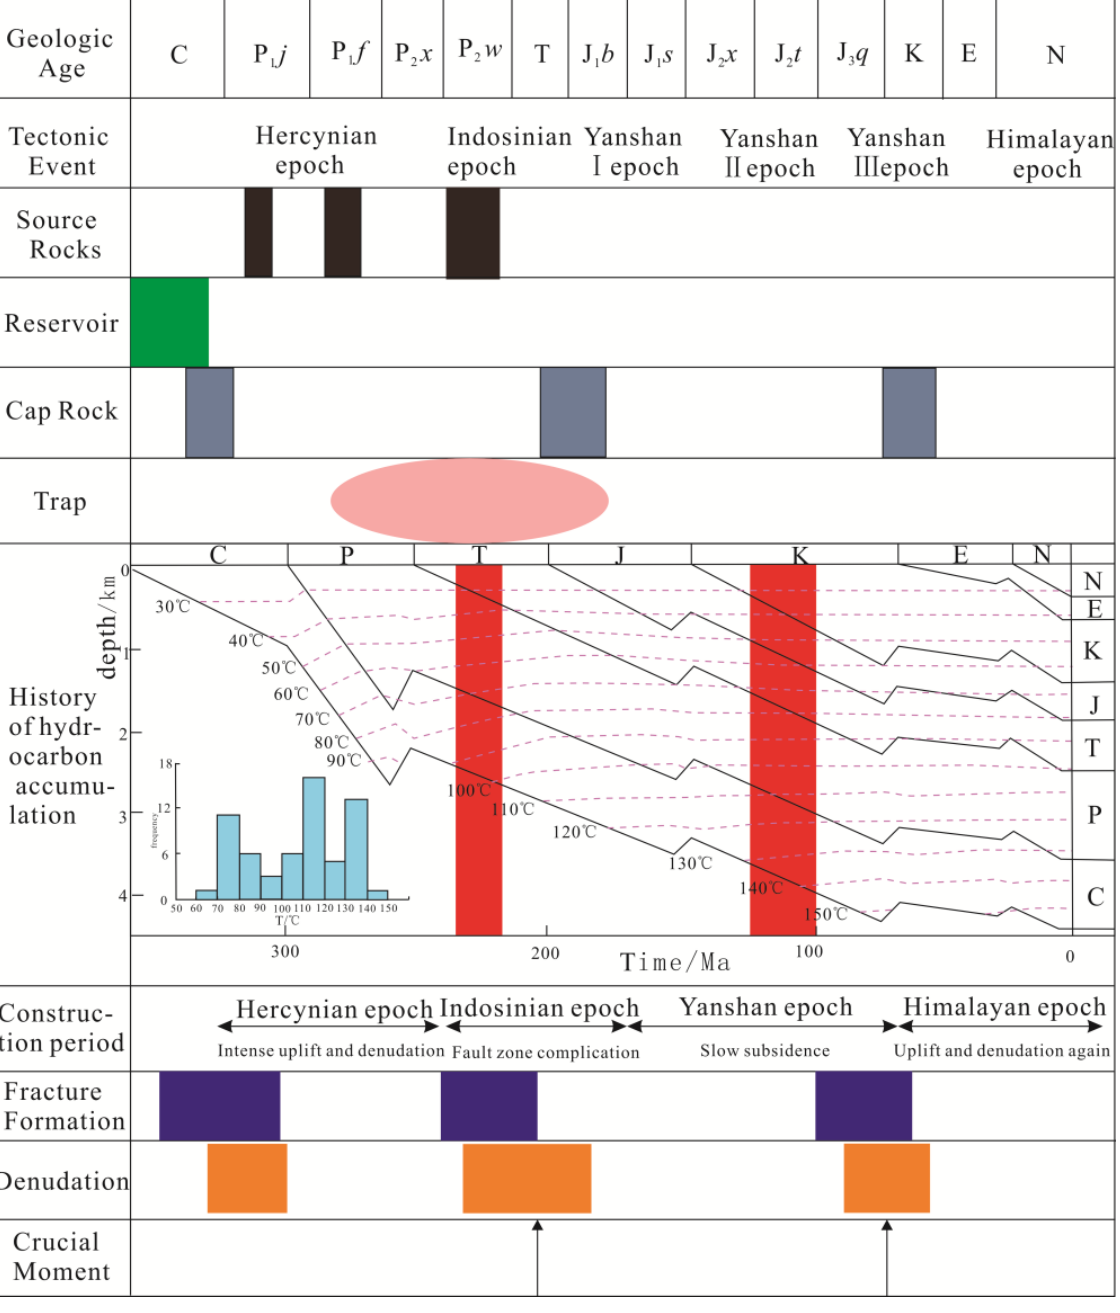
Figure 10. Hydrocarbon accumulation and evolution history of Carboniferous reservoirs in Chepaizi area.